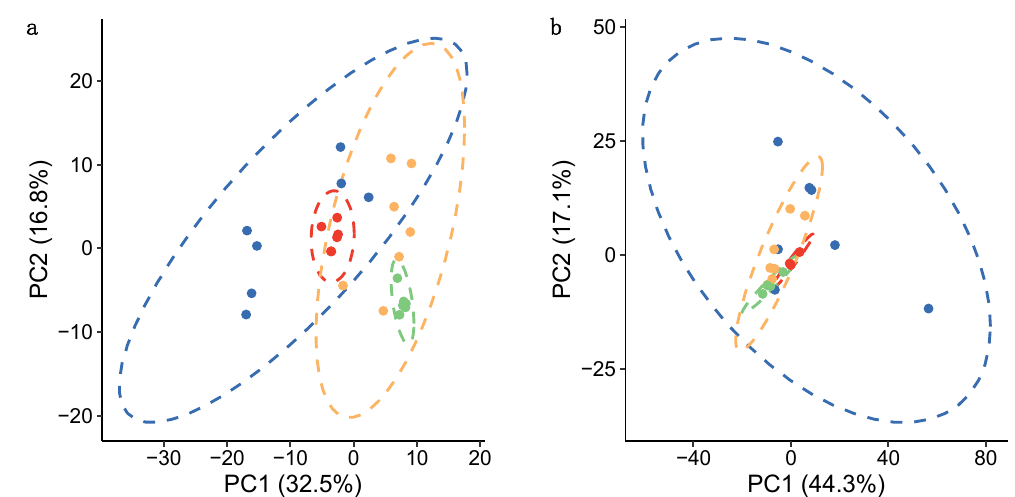
Figure 1. PCA score plots visualising the metabolic differences between samples harvested by centrifugation or filtration as measured by (a) nESI-DIMS polar metabolomics (positive ion mode) and (b) nESI-DIMS lipidomics (positive ion mode). Replicate samples are colour coded as: centrifugation—biological replicates; centrifugation—technical replicates; filtration—biological replicates; and filtration—technical replicates. Dashed lines show 95% confidence intervals for each group of samples. Table 1. Metrics used to evaluate the relative coverage of the microtissue metabolome/lipidome ( m / z feature count), technical reproducibility (mRSD across technical replicates) and total reproducibility (mRSD across biological replicates) for pooled microtissues sampled by either centrifugation- or filtration-based approaches and all analysed by nESI-DIMS metabolomics and lipidomics (positive ion mode). Assay Feature count 1697 across technical replicates (%) Total variation: median RSD across biological replicates (%)